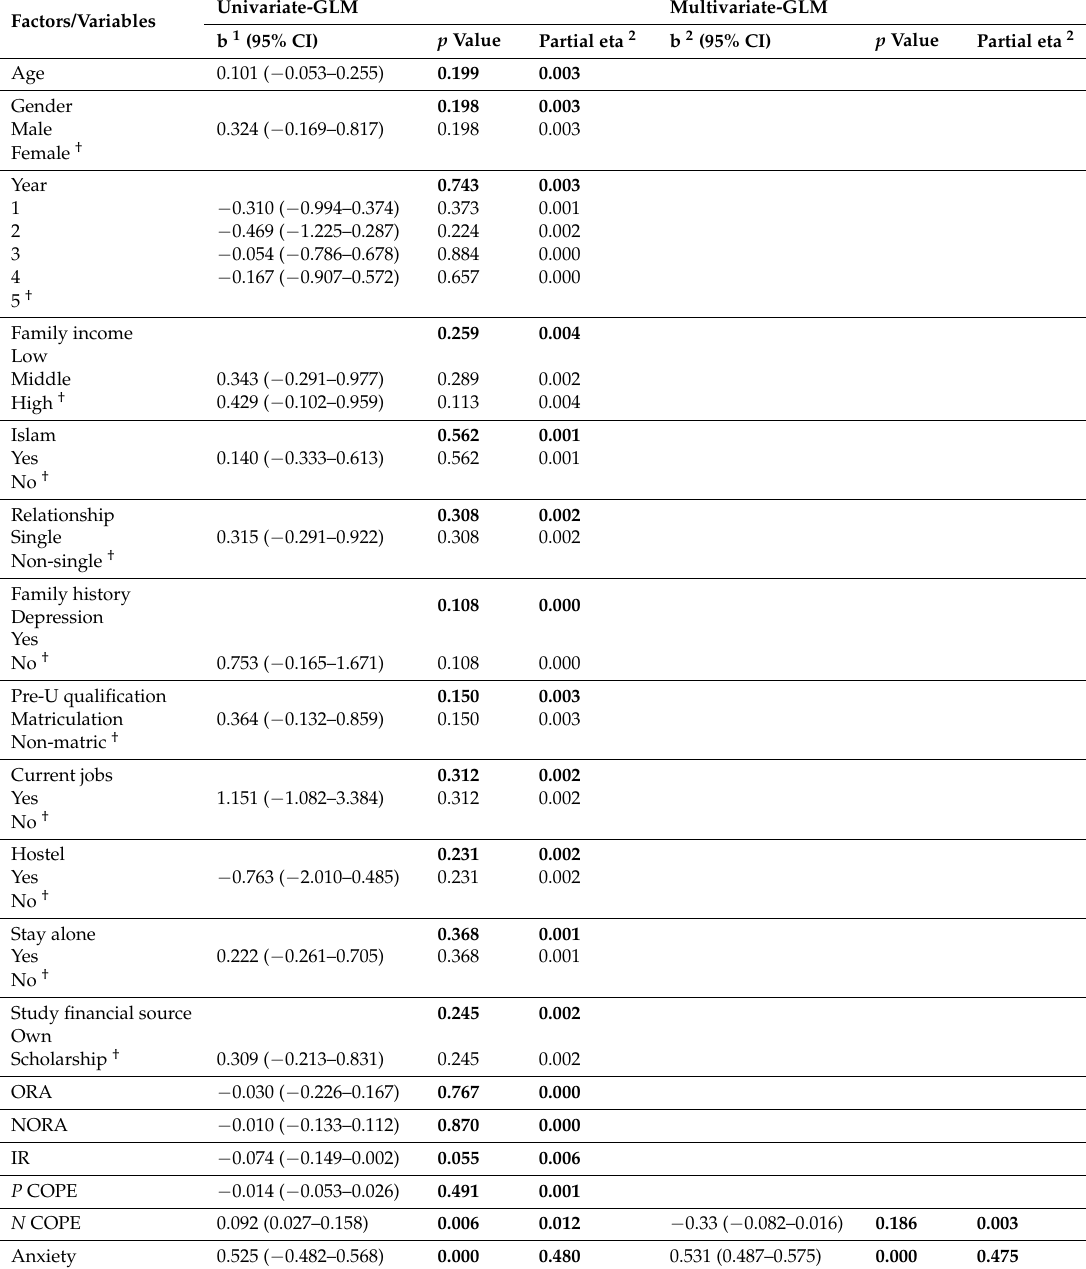
Table 7. General Linear Model on factors associated to depression based on ( n =